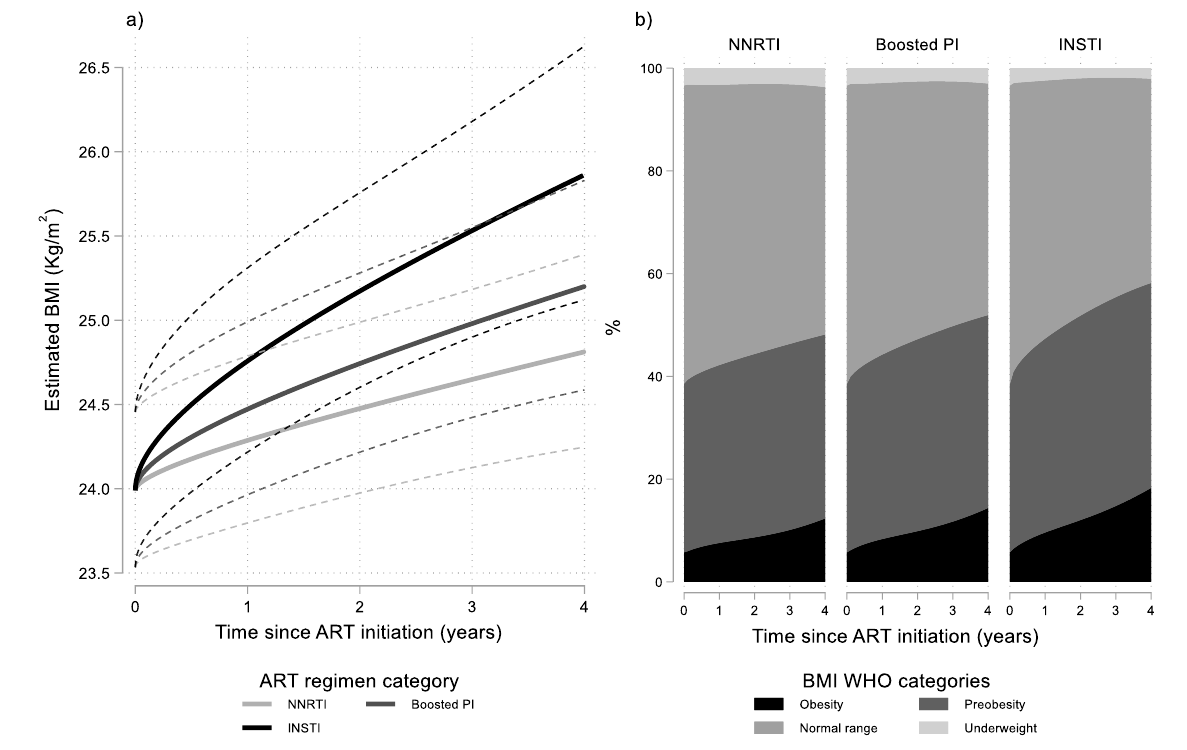
Figure 1. Results from multivariable linear mixed model: ( a ) estimated BMI (95% CI) after cART initiation by ART regimen category and baseline BMI; and ( b ) estimated probabilities for BMI WHO categories by time since ART initiation and ART regimen category. Estimates shown for men having sex with men (MSM), aged 30–39, with no AIDS and with 10,000–49,999 HIV-RNA copies/mL at baseline. Table 3. Estimated probabilities of belonging to one of the body mass index WHO categories by time since ART initiation and ART regimen category. Estimates shown for men having sex with men, aged 30–39, with no AIDS and with 10,000–49,999 HIV-RNA copies/mL at